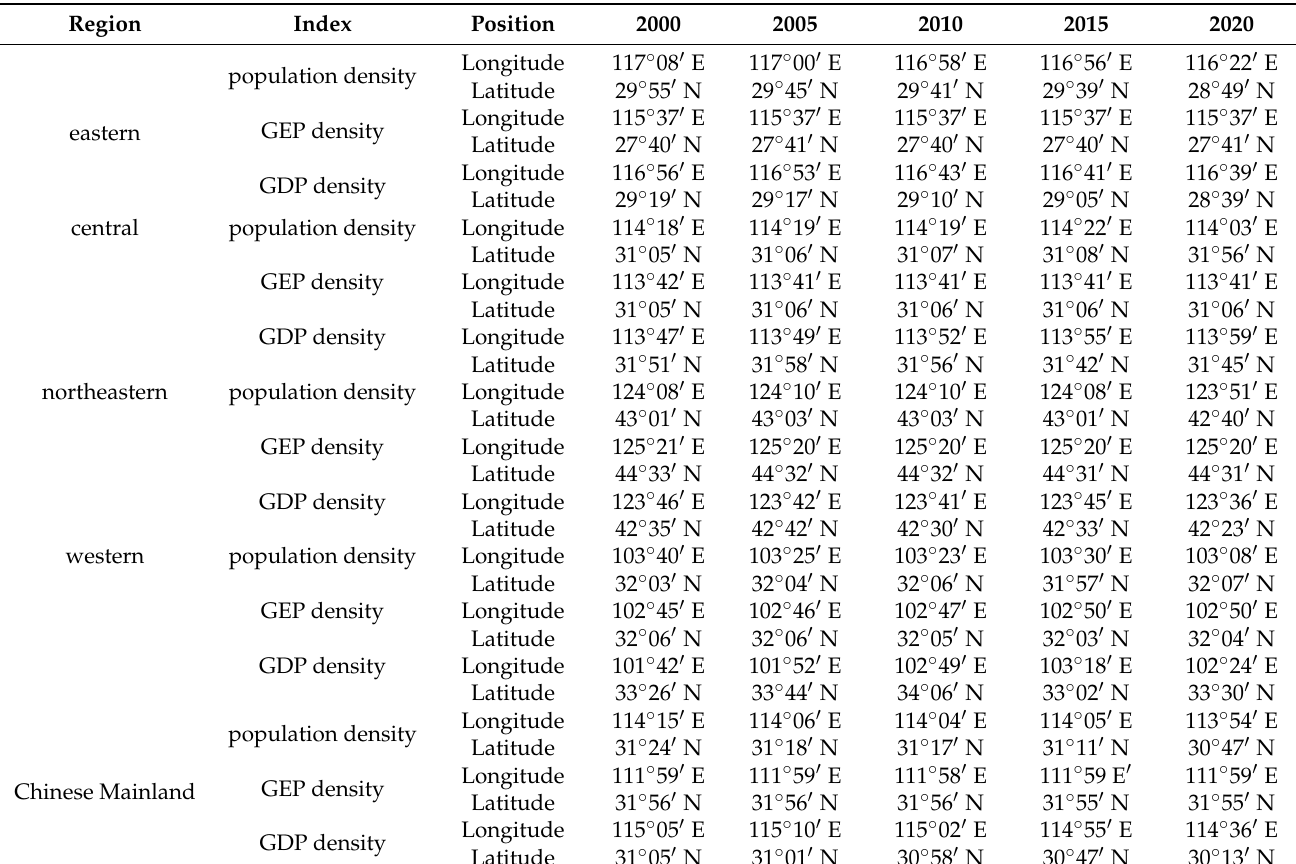
Table 2. Location of center of gravity of population density, gross ecosystem production density and gross domestic production density in Chinese Mainland during the investigation period.